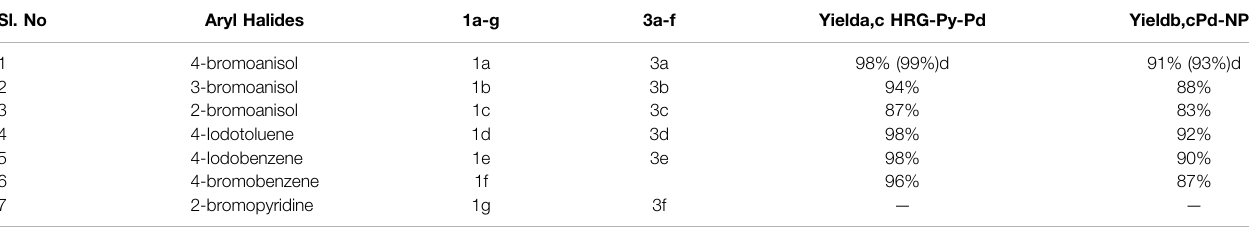
TABLE 3 | Mizoroki-Heck reaction catalyzed by HRG-Py-Pd and Pd-NPs nanocatalysts, Substrate scope. Sl. No